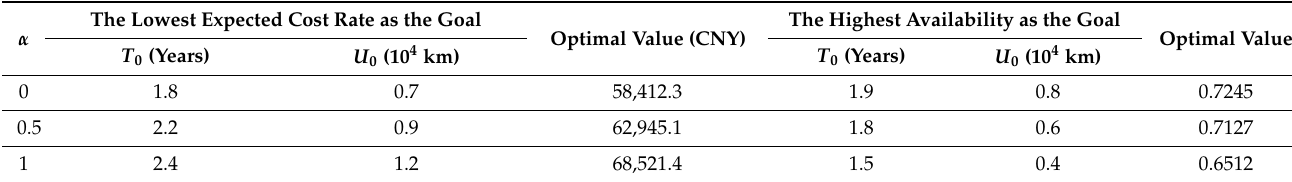
Table 7. The optimal scheme under